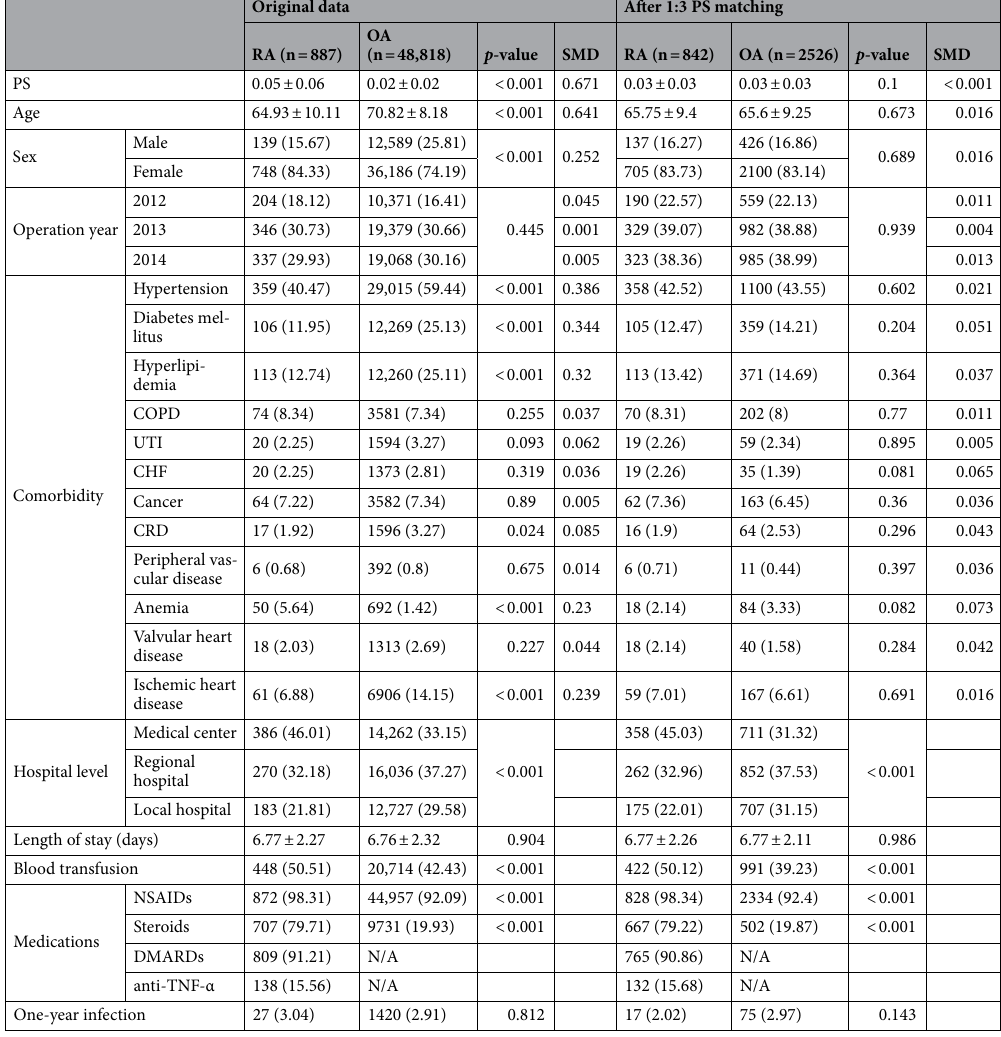
Table 2. Characteristics of the study population at baseline and one-year follow-up after TKA. CI, confidence interval; CHF, congestive heart failure; COPD, chronic obstructive pulmonary disease; CRD, chronic renal disease; N/A, not applicable; NSAIDs, nonsteroidal anti-inflammatory drugs; OA, osteoarthritis; OR, odds ratio; PS, propensity score; RA, rheumatoid arthritis; SMD, standardized mean difference; UTI, urinary tract